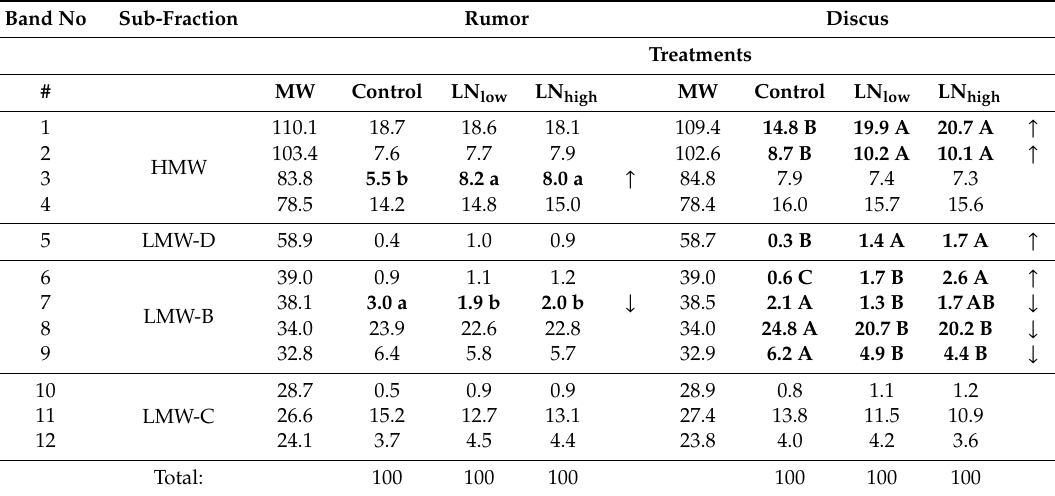
Table 5. Relative protein concentration (% of total lane intensity) of glutenin bands in response to late N fertilization for the two cultivars Rumor and Discus.